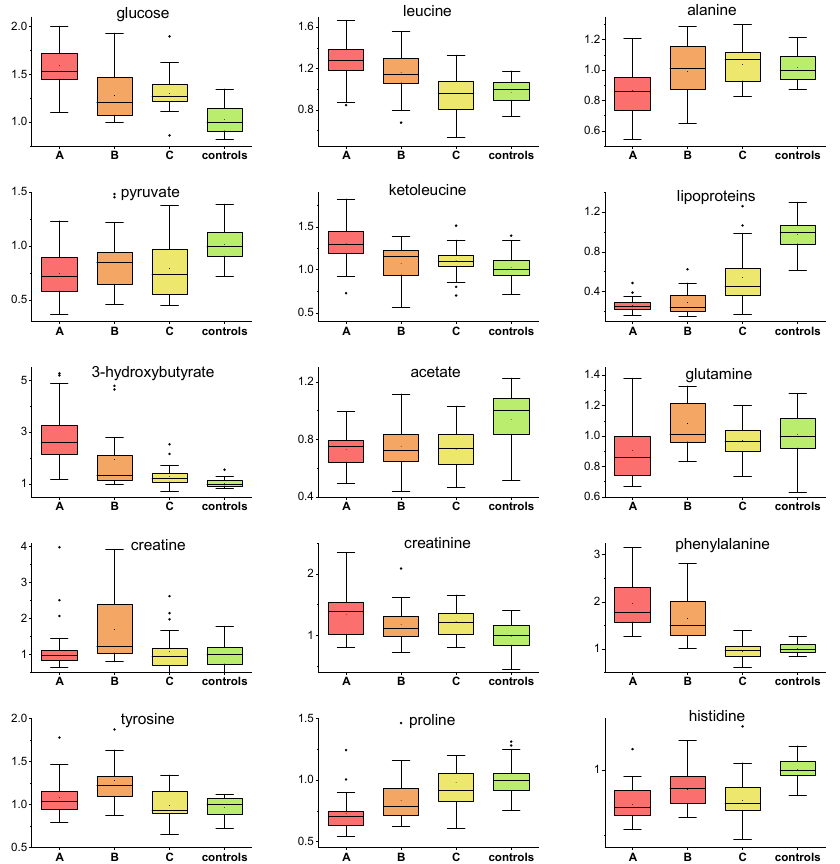
Figure 3. Relative concentrations of plasma metabolites in patients in three various sampling times and controls, values related to median of controls set to 1.